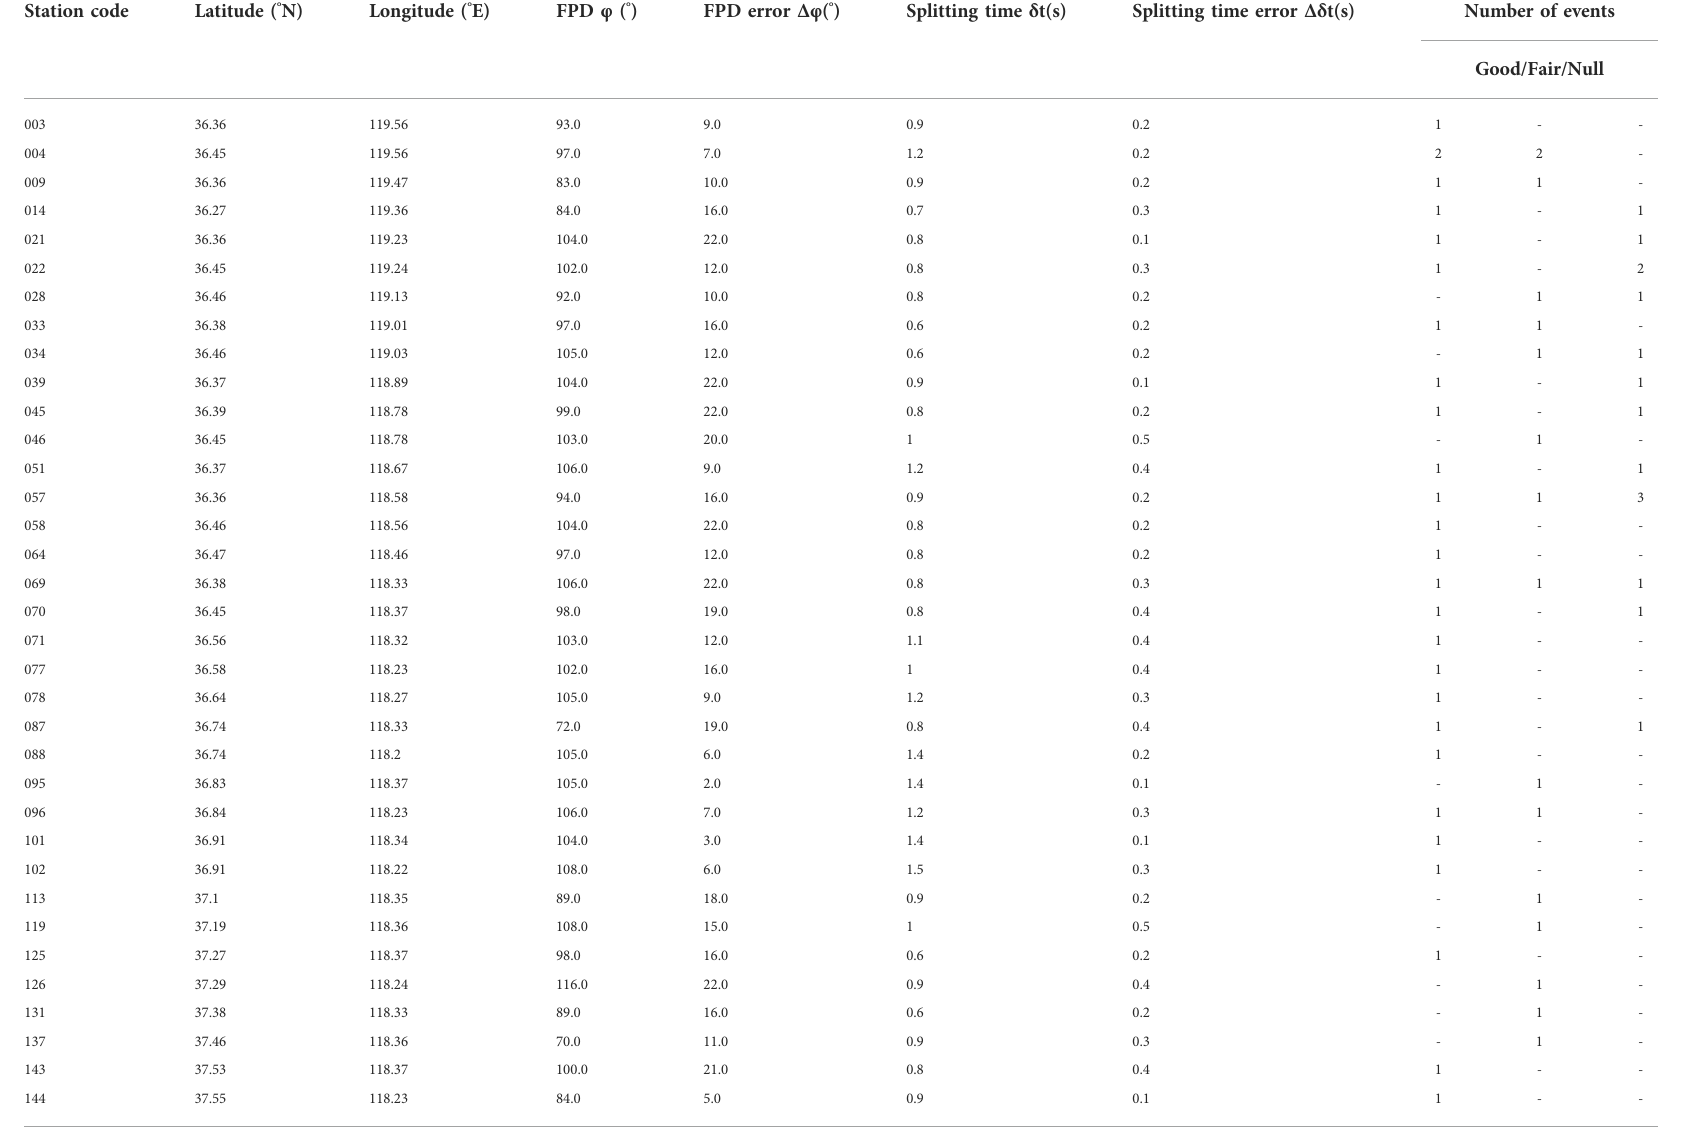
TABLE 1 The obtained valid SKS splitting results at 35 seismic stations around the Luxi uplift segment of the Tanlu fault zone. Station